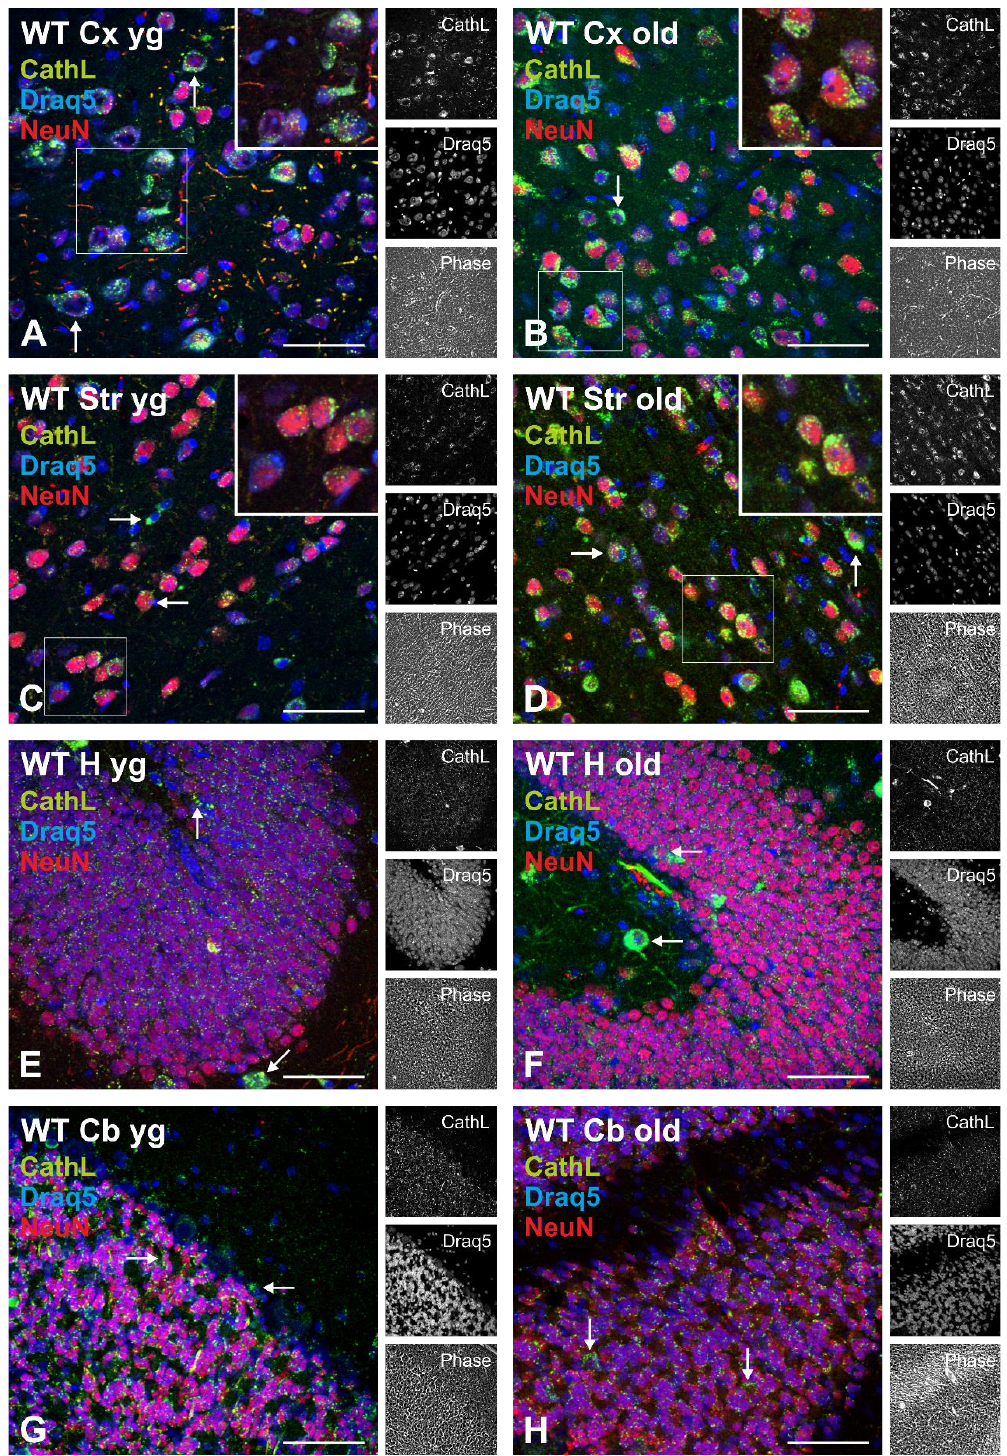
Figure 3. Distribution and localization of cathepsin L in the CNS of young and aged WT mice. ( A – H ) Cathepsin L localization in CNS of WT young ( A , C , E , G , 5–7 months old) and aged ( B , D , F , H , 18–20 months old) mice using confocal scanning microscopy (green, cathepsin L; blue, Draq5™ nuclear stain; red, NeuN neuronal marker). Boxed areas in ( A – D ) are magnified in the respective inserts (top right). Like cathepsin B, cathepsin L was localized in a vesicular pattern (arrows) in neuronal cells and other brain cells in cortex ( A , B ), striatum ( C , D ), and hippocampus ( E , F ), and cerebellum ( G , H ). Scale bars: 50 µ